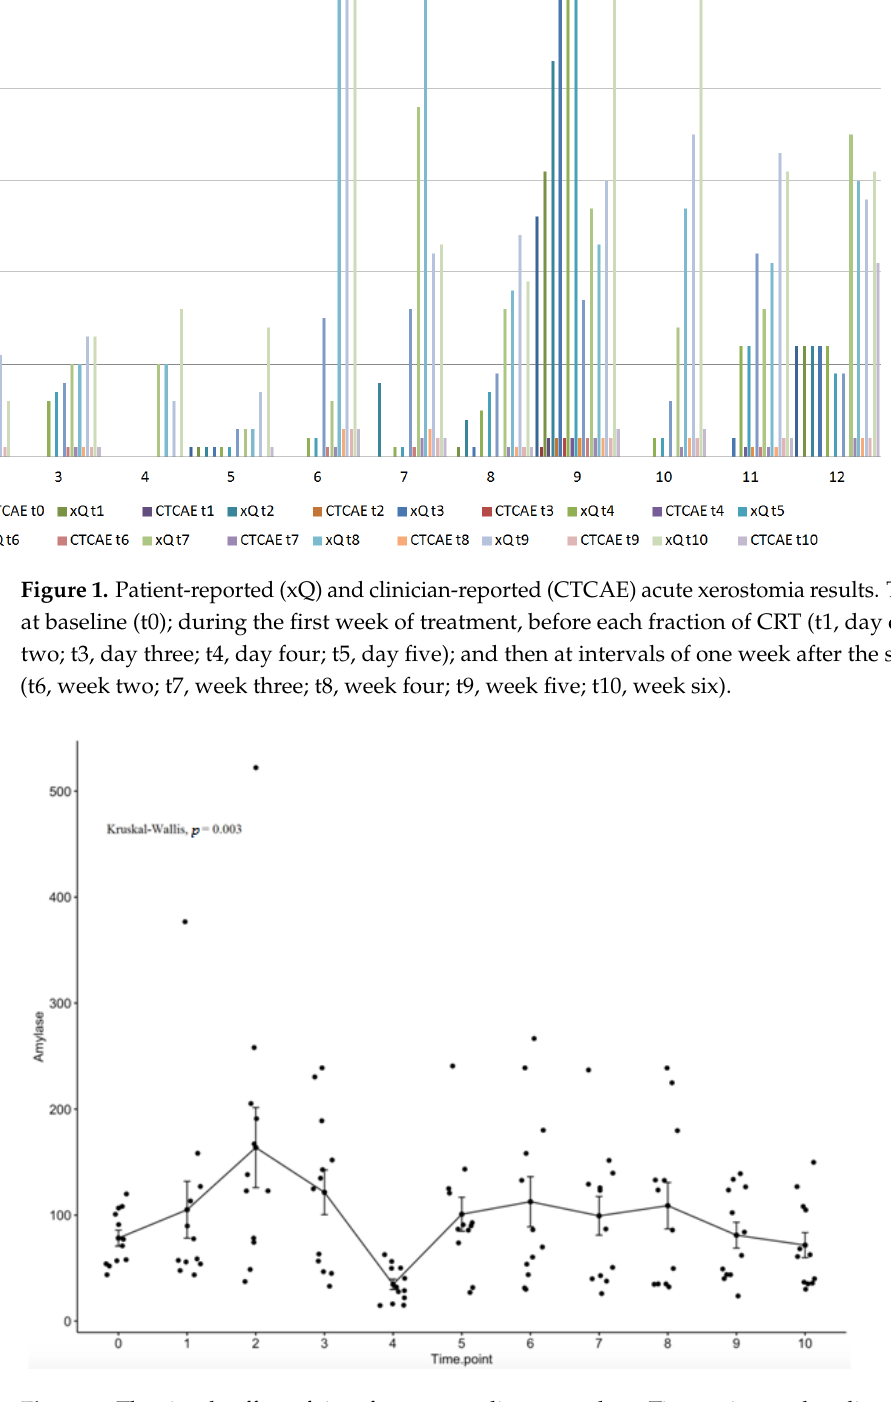
Figure 2. The simple effect of time for serum salivary amylase. Time points: at baseline (t0); during the first week of treatment, before each fraction of CRT (t1, day one; t2, day two; t3, day three; t4, day four; t5, day five); and then at intervals of one week after the start of CRT (t6, week two; t7, week three; t8, week four; t9, week five; t10, week six).